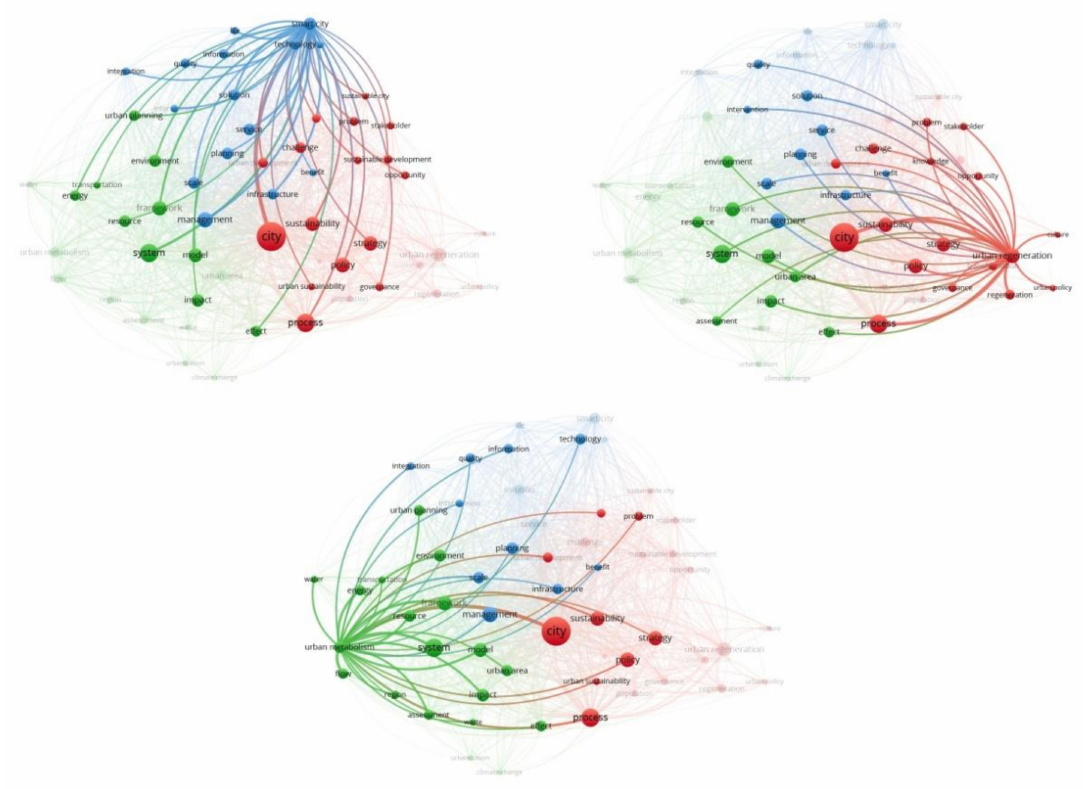
Figure 8. Links between main keywords under co-occurrence